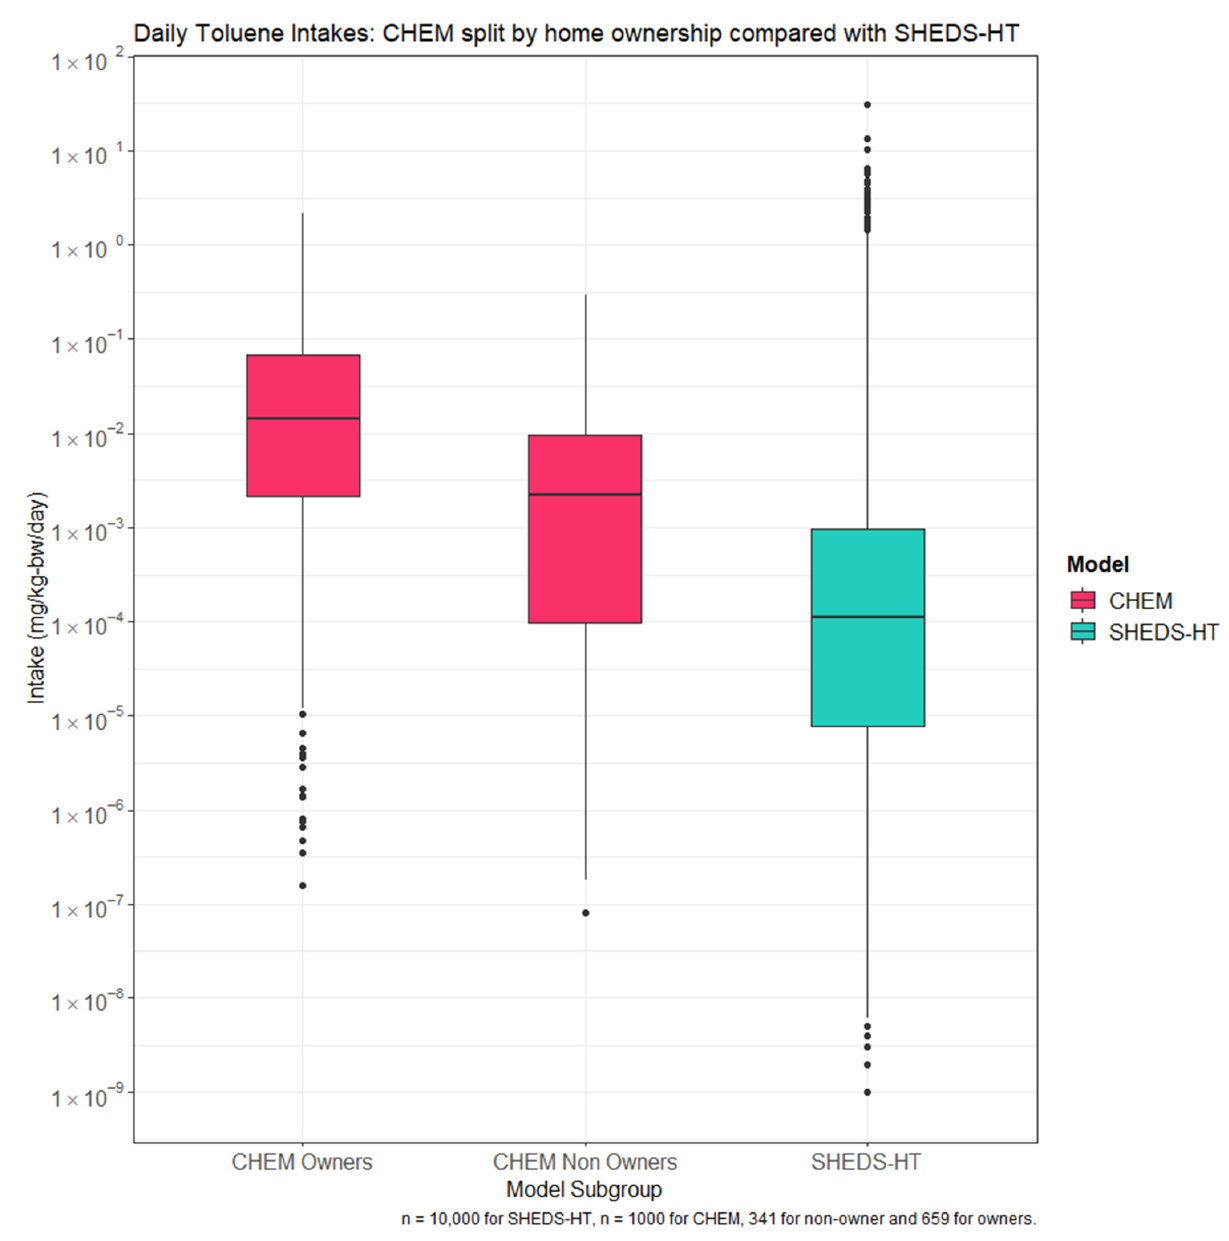
Figure 6. Daily toluene intakes across CHEM owners, non-owners, and SHEDS-HT. An additional run for product use categories (PUCS) only pertaining to home owner- ship was also performed. The mean daily intake of these households, among households with registered exposures, was 0.71 mg/kg-bw/day, compared to 0.78 mg/kg-bw/day for owners with all PUCS in the previous all-inclusive run. Given this, approximately 91% of a homeowner’s toluene exposure is from PUCS pertaining to owning a home. However, non-homeowners have a mean exposure of 0.30 mg/kg-bw/day, so the relative contribu- tion to total exposure is not characterized by the delta of the all-inclusive homeowner run and the homeowner PUCs only run. This is because PUS assigns other activities that result in exposures for non-homeowners when homeowners would be performing homeowner unique tasks. Rather, CHEM provides an estimated baseline of 0.30 mg/kg-bw/day for non-homeowners, which increases to 0.78 mg/kg-bw/day for homeowners, of which 91%